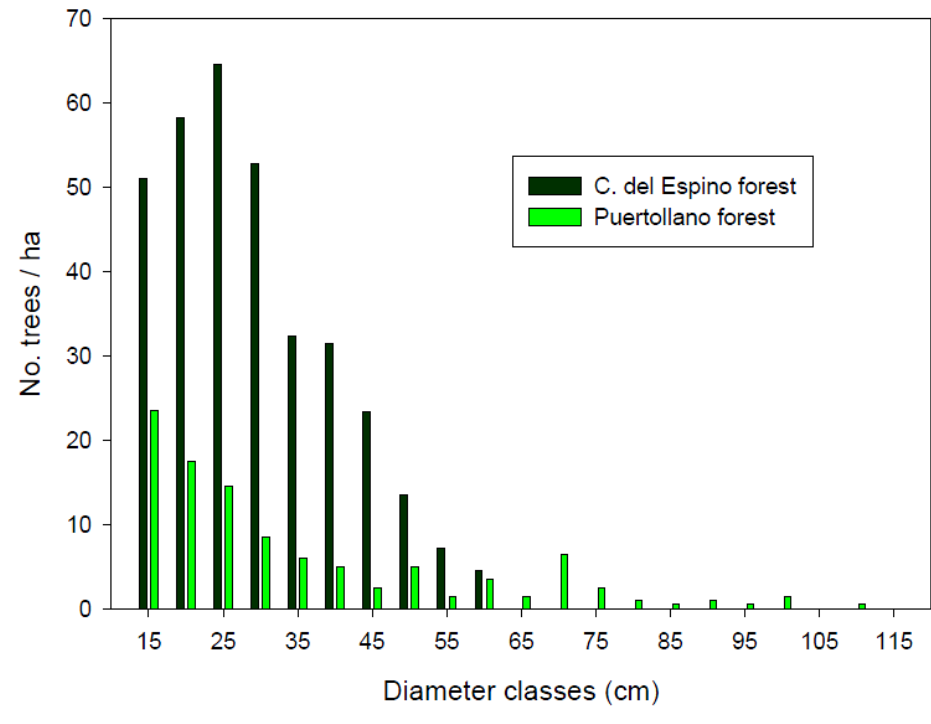
Figure 2. Diameter size distribution from the two study forests. C. del Espino is